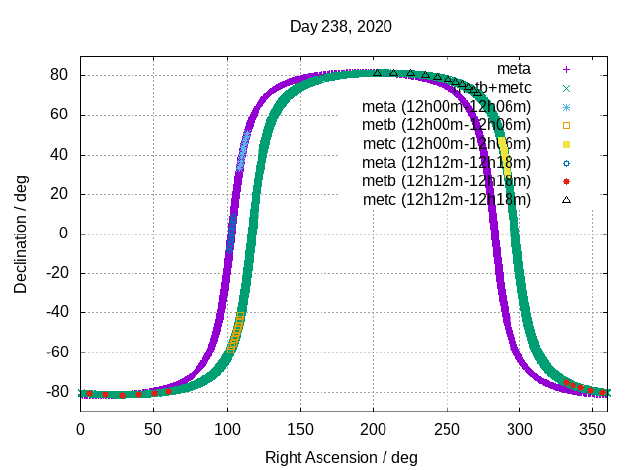
Figure 8. Footprint of the orbits of meta, metb, metc MetOp LEOs, for day 238 of year 2020, showing the displacement between 12 h 00 m–12 h 06 m and 12 h 12 m–12 h 18